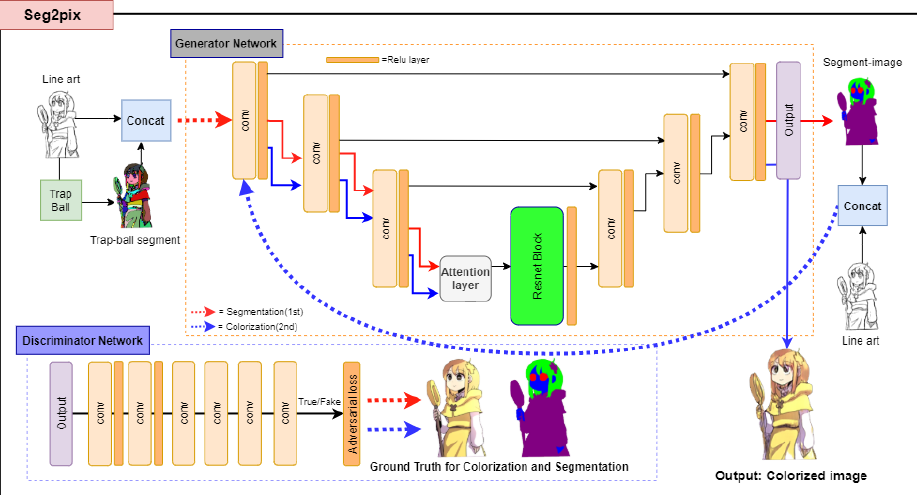
Figure 5. The architecture of the generator and discriminator network. Two types of ground truth are required: one is the hand-labeled segmented image, and the other is the colorized original image. Seg2pix generates both desired outputs by a two-step training using the same architecture of the network, and this training is accomplished by end-to-end